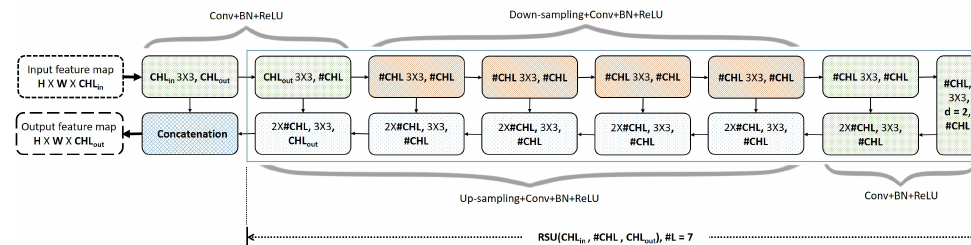
Figure 8. General structure of RSU